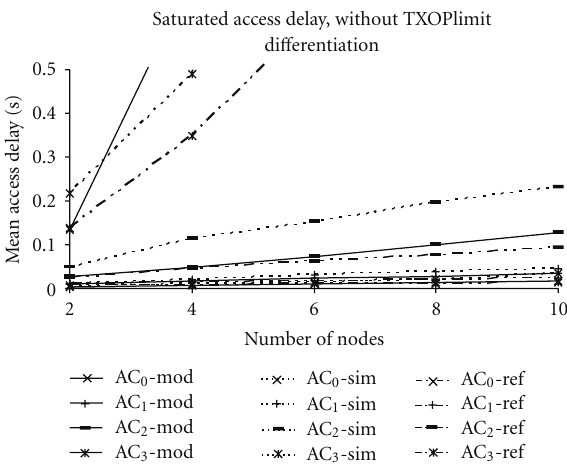
Figure 16: Mean access delay per AC, without